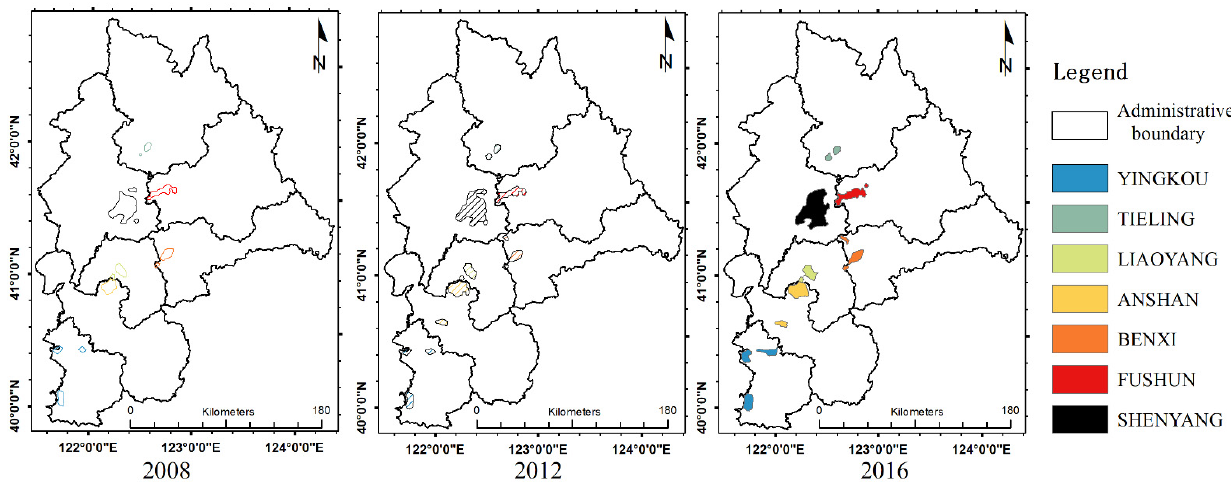
Figure 6. Built-up area of central Liaoning urban